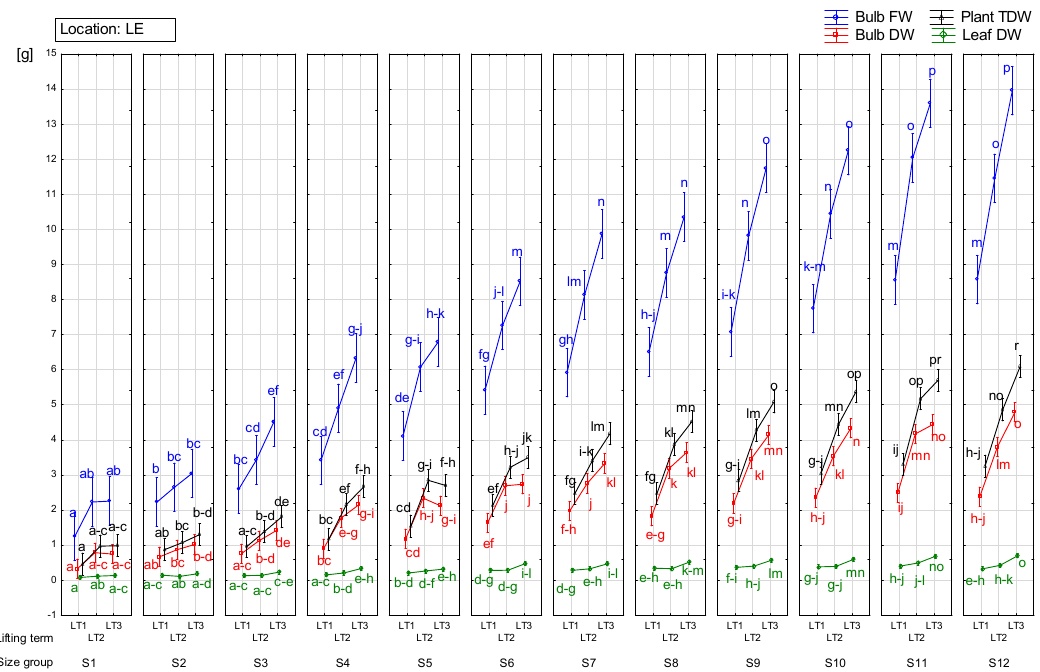
Figure 3. Effect of size group and lifting term on measured DW and FW of organs parameters for Lednice (LE) location. Mean values within the same color with different letter are significantly different according to Duncan’s multiple range test at p ≤ 0.05. For treatments description, see Sections 2.1–2.4, Materials and Methods sections.